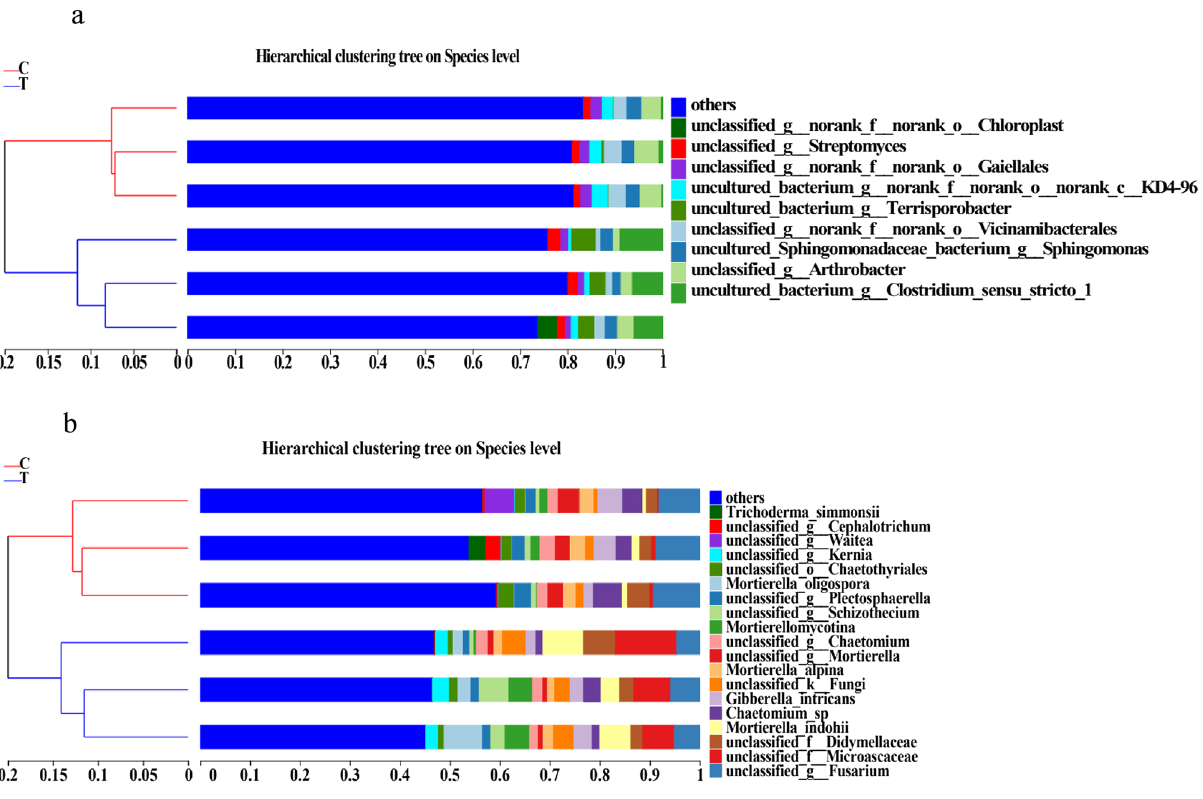
Figure 6. Hierarchical clustering analysis showing the changes in the composition of bacterial ( a ) and fungal ( b ) communities.